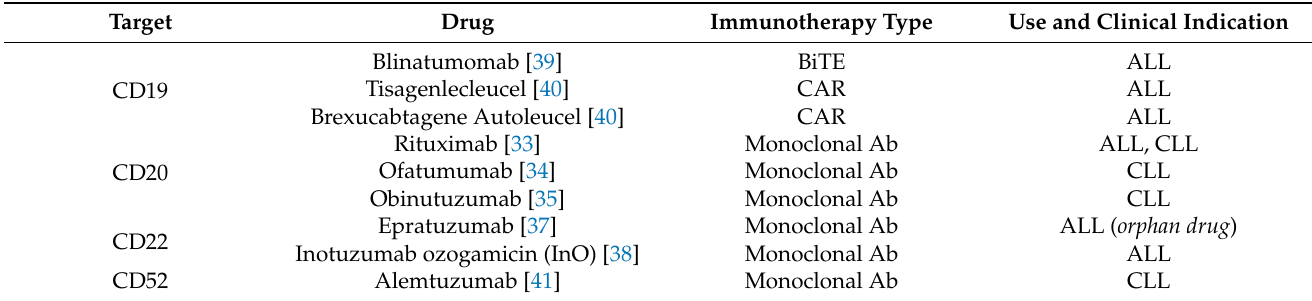
Table 1. Different immunotherapies used for treating ALL and/or